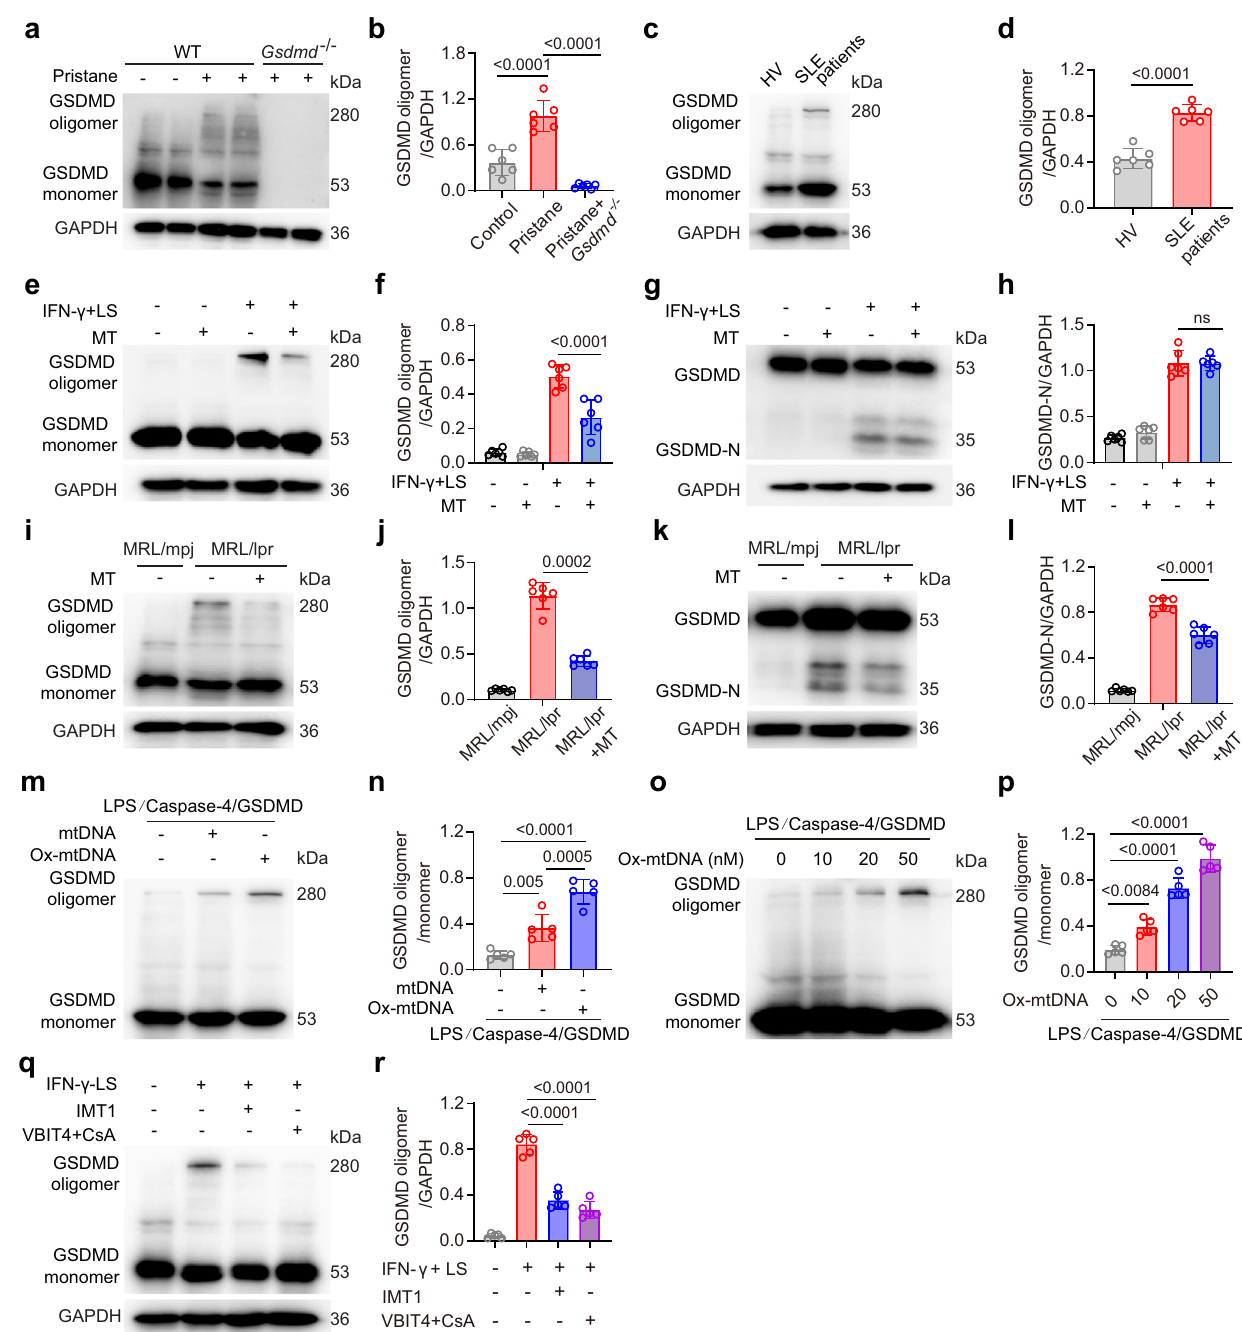
Fig. 6 | Oxidized mtDNA promotes GSDMD oligomerization. a Non-reducing immunoblottingofGSDMDoligomerinBMneutrophilsisolatedfromWT,PILmice and Gsdmd − / − mice after pristane treatment. b Quantitative analysis of GSDMD oligomer/GAPDH. c Non-reducing immunoblotting of GSDMD in neutrophils from HVandSLEpatients. d QuantitativeanalysisofGSDMDoligomer/GAPDH. n =6HVs or 6 SLE patients. e Non-reducing immunoblotting of GSDMD oligomer in murine BM neutrophils. Cells were treated with IFN- γ plus LS, or pretreated with Mito- TEMPO. f Quantitative analysis of GSDMD oligomer/GAPDH. g Immunoblotting of GSDMD in murine BM neutrophils. Cells were treated with IFN- γ plus LS, or pre- treated with Mito-TEMPO. h Quantitative analysis of GSDMD-N/GAPDH. i Non- reducing immunoblotting of GSDMD oligomer in BM neutrophils isolated from MRL/mpj, MRL/lpr or MRL/lpr after Mito-TEMPO treatment. j Quantitative analysis of GSDMD oligomer/GAPDH. k Immunoblotting of GSDMD in BM neutrophils isolated from MRL/mpj, MRL/lpr and MRL/lpr after Mito-TEMPO treatment.